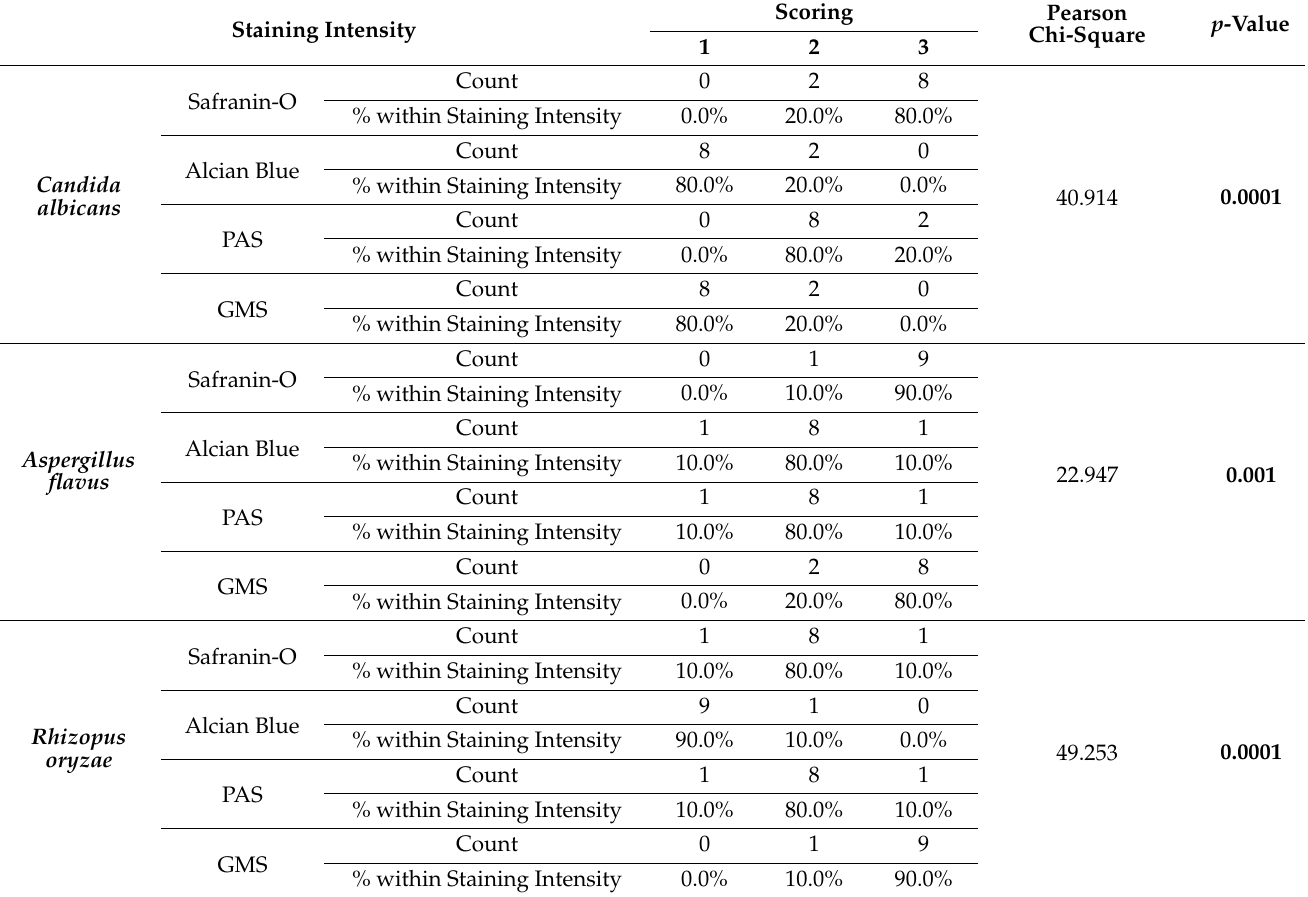
Comparison of staining intensity of spores of Candida albicans , Aspergillus flavus and Rhizopus oryzae